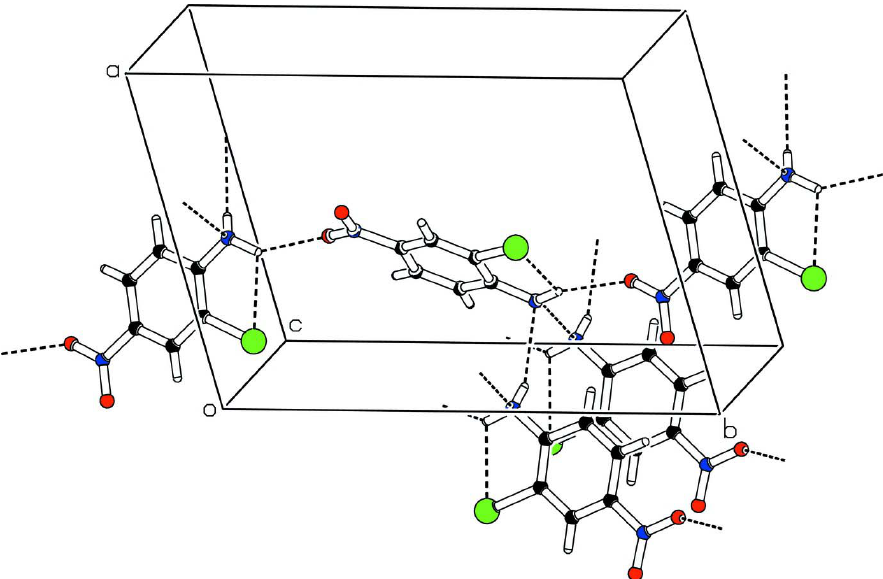
Figure 2 A partial packing diagram of the title compound. Hydrogen bonds are shown as dashed